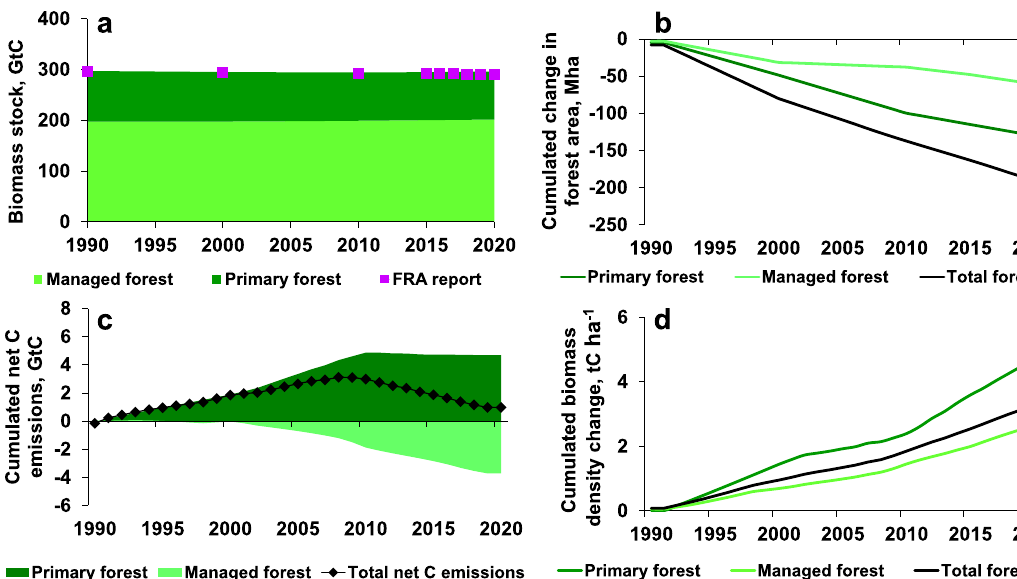
Fig. 1 Global trends in total, primary, and managed forests. a Forest biomass C stocks (GtC); b cumulated change in forest area (Mha; negative values indicate area loss); c cumulated C net emissions (GtC; positive values indicate a C source while negative values indicate a C sink); and d cumulated net change in C-stock densities (tC/ha). See Supplementary Fig. 1 for annual fl